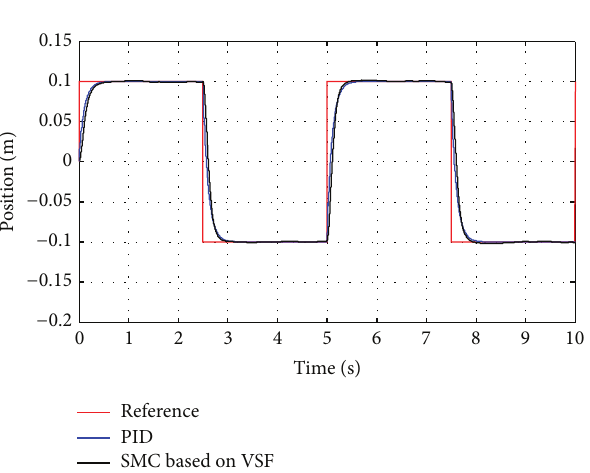
Figure 8: Comparison of the tracking performance.